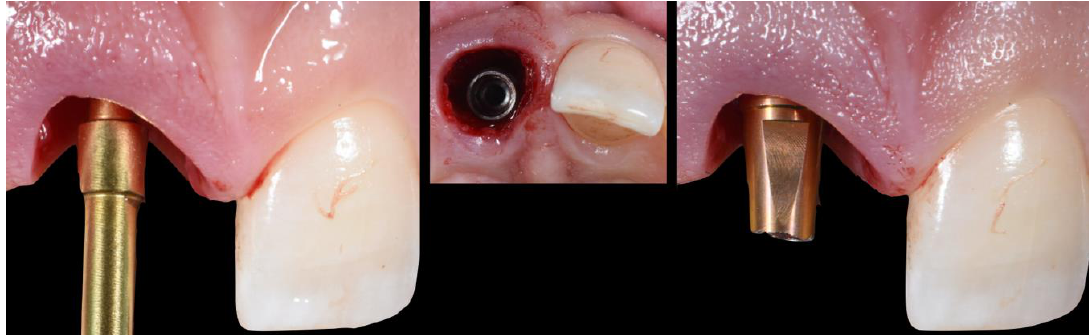
Figure 5. Osteotomy, occlusal view of the implant position, abutment adjustment, and connection. Step 4.